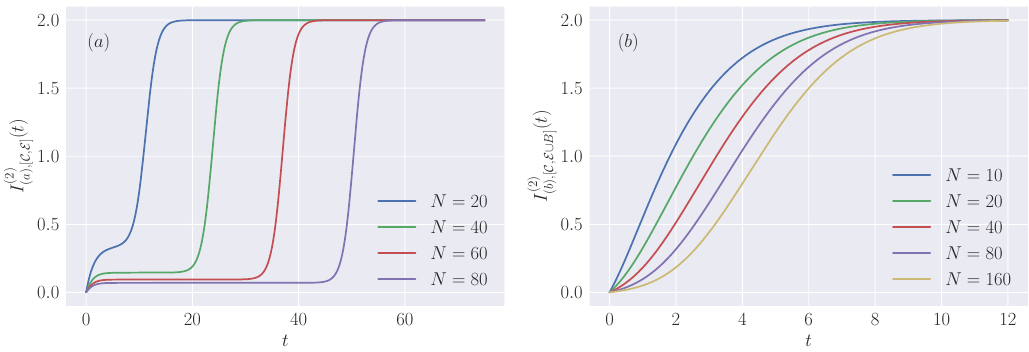
Figure 9 . Sub(cid:12)gure ( a ): mutual information I (2) displayed in (cid:12)gure 8( a ), and increasing values of N . Sub(cid:12)gure ( b ): mutual information I (2) [de(cid:12)ned in eq. (4.3)] for the setting displayed in (cid:12)gure 8( b ), and increasing values of N . For both plots, the evolution is driven by the maximally chaotic RUC of section 2 (without conserved